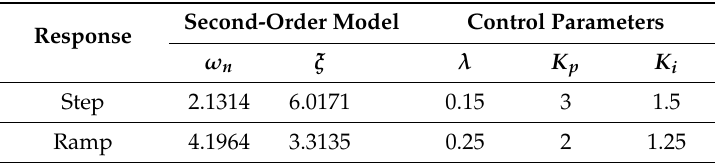
Table 5. Model and control parameters for step and ramp